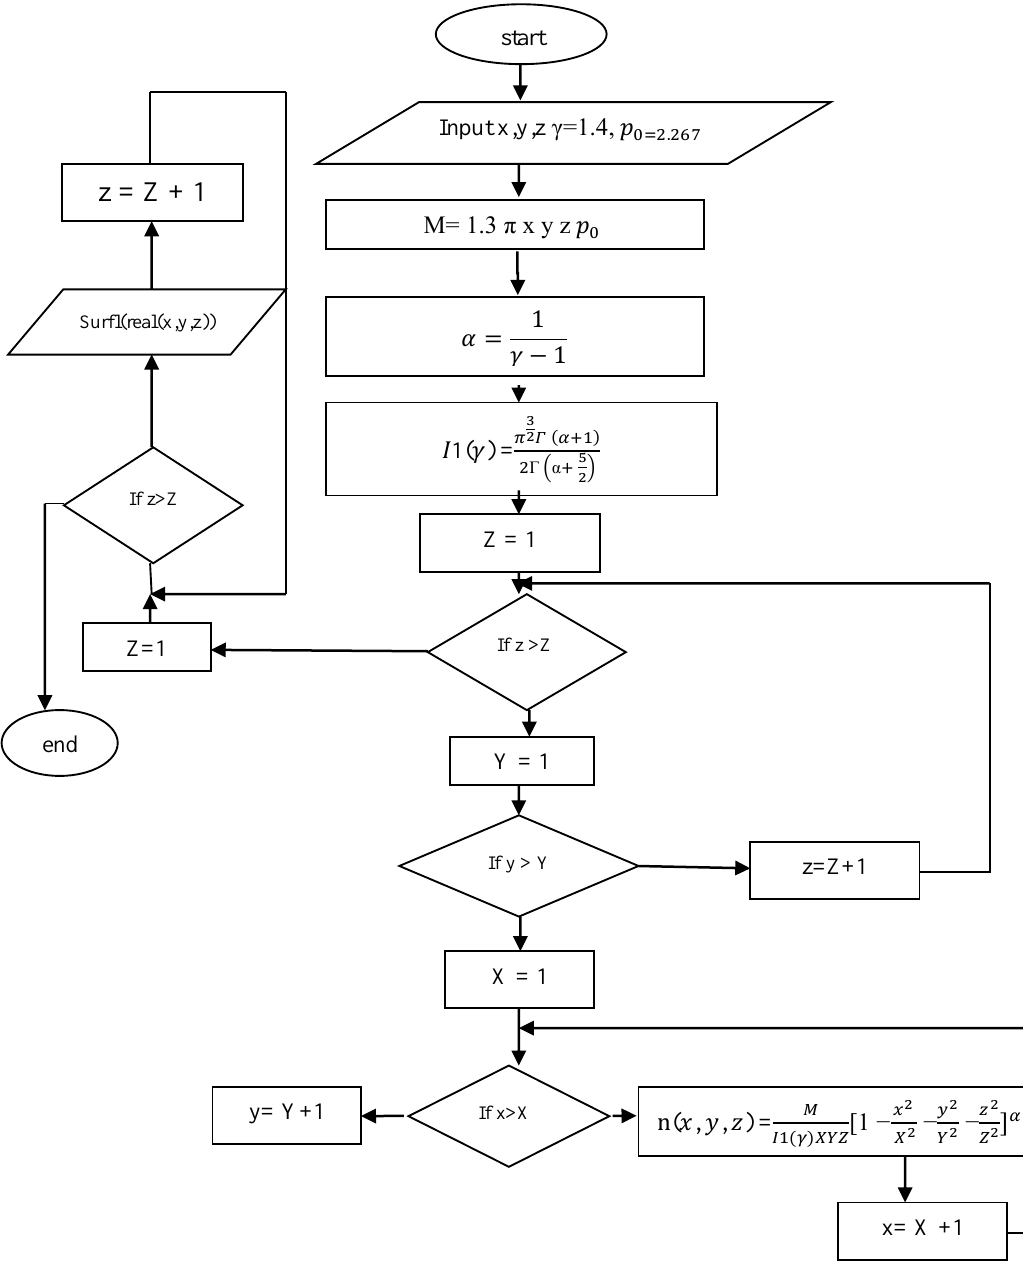
Figure 2: The algorithm of the Anisimov model Matlab